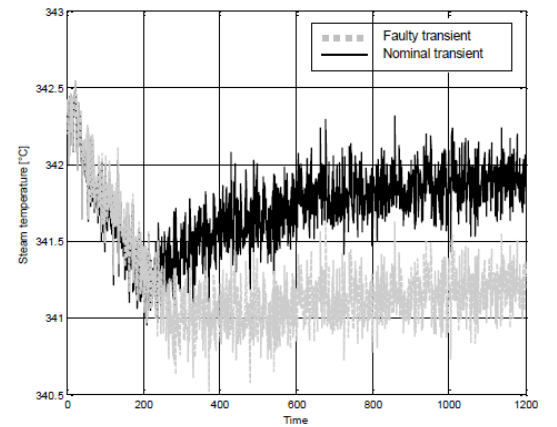
Fig. 17. Evolution of the steam temperature for a nominal transient and the faulty